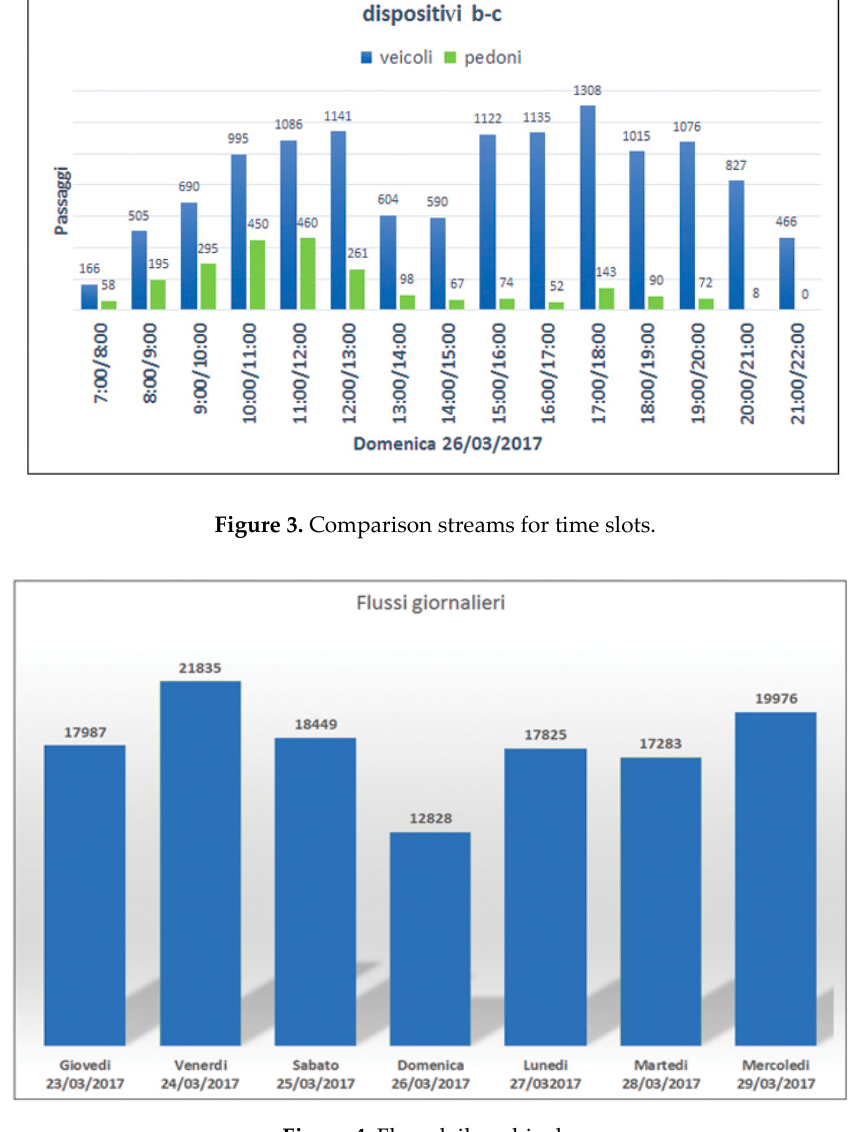
Figure 4. Flow daily